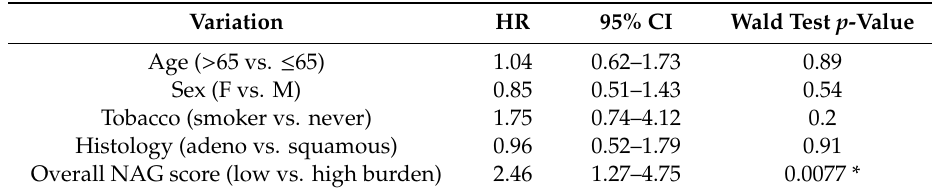
Table 1. Multivariate survival model of NAG score with clinical-pathological factors of TCGA NSCLC stage I